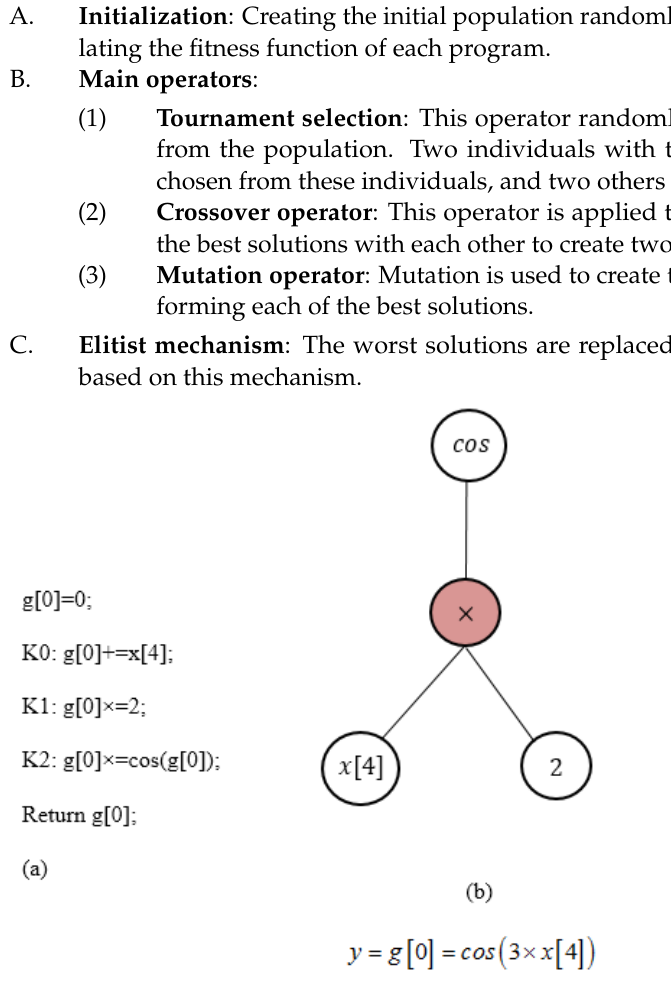
Figure 3. Comparison between ( a ) GP and ( b ) LGP structure. Table 3. The characteristics and setting parameters of proposed AI-based approaches.